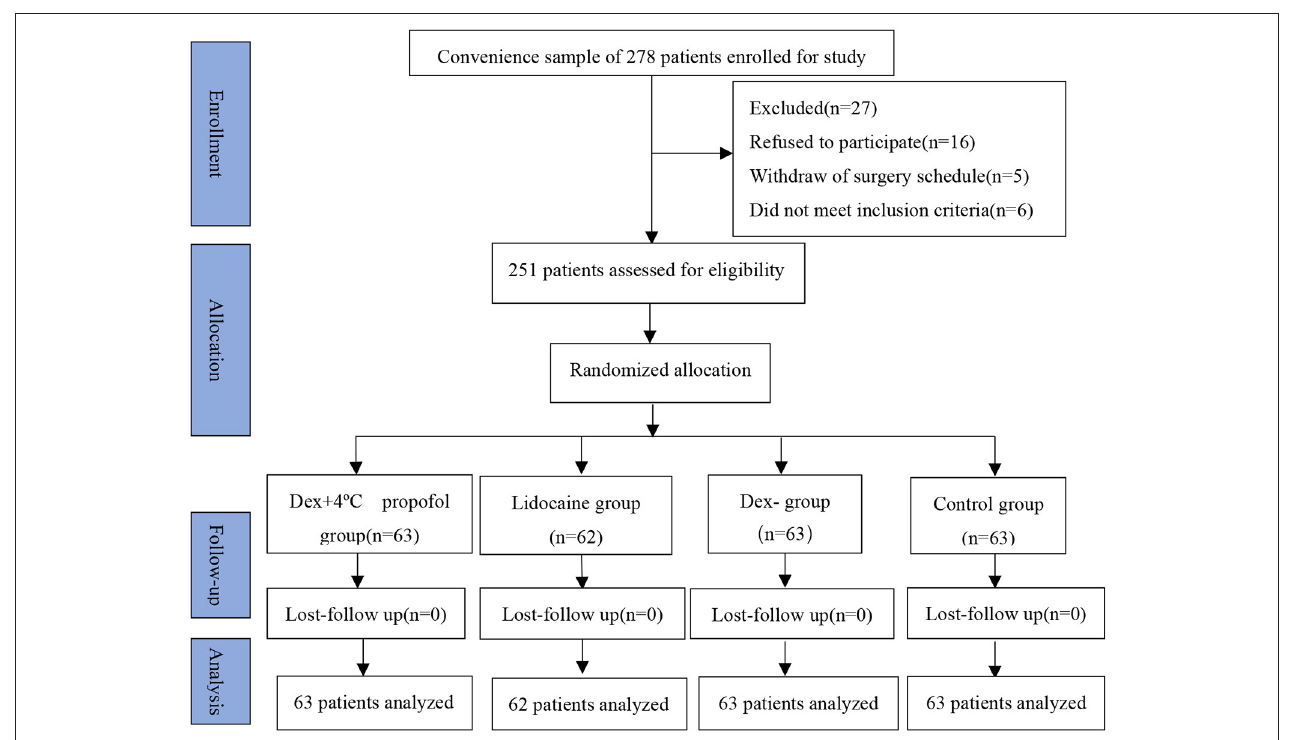
FIGURE 1 | CONSORT flow diagram of the